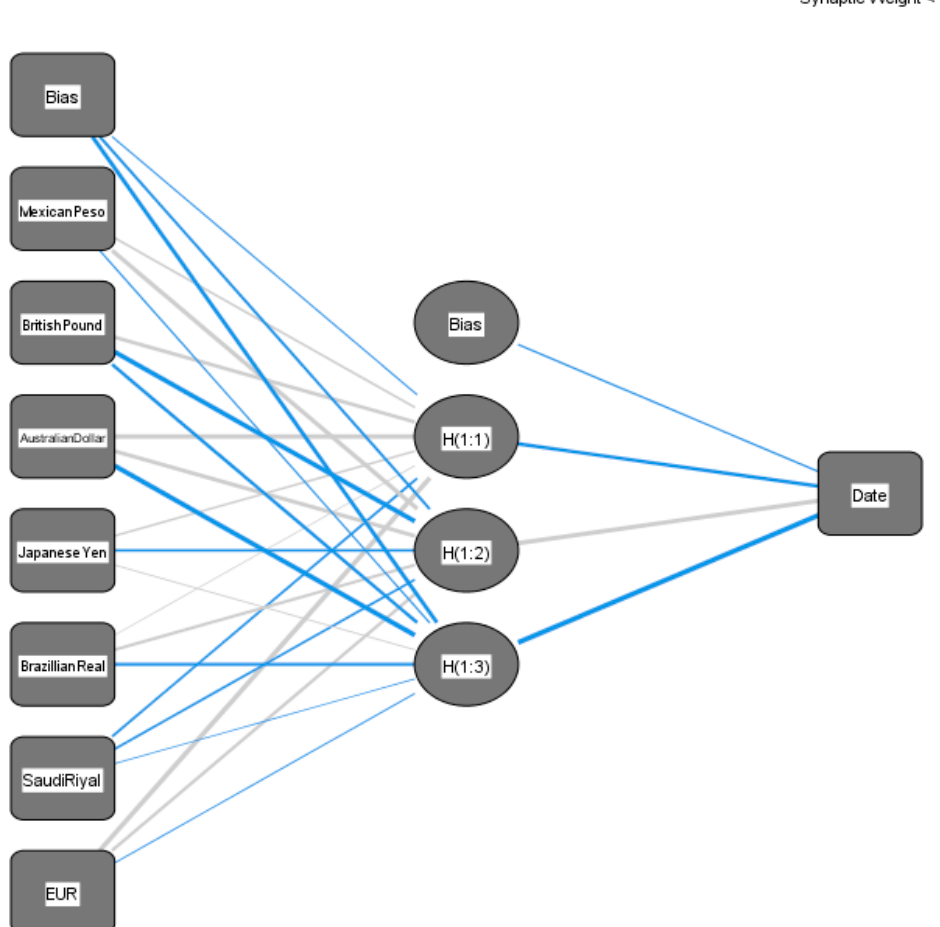
Figure 7. Function of backpropagation neural network.